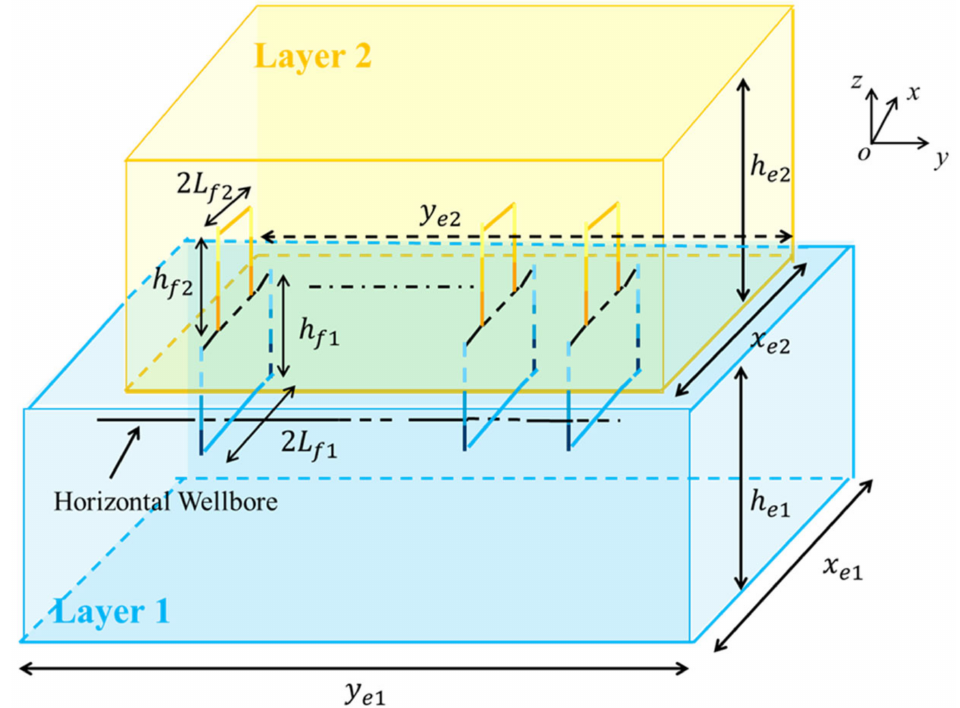
Figure 2. Schematic of a fractured horizontal well with N stage transverse fractures producing from a two-layer